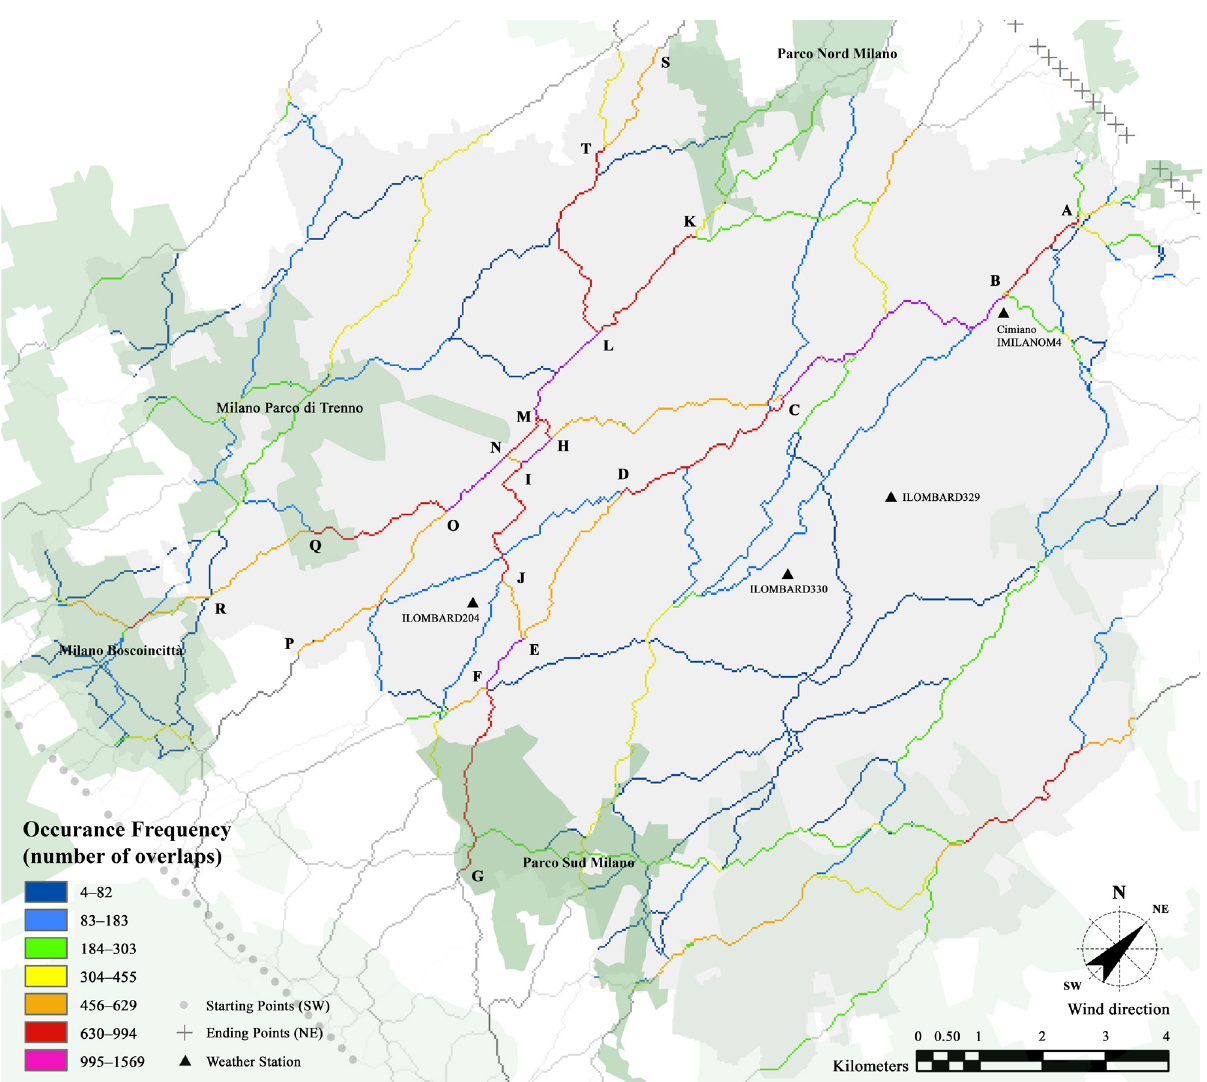
Figure 5. Retrieved ventilation corridors in SW-NE direction and occurrence frequency, using canyon orientations and LCP analysis